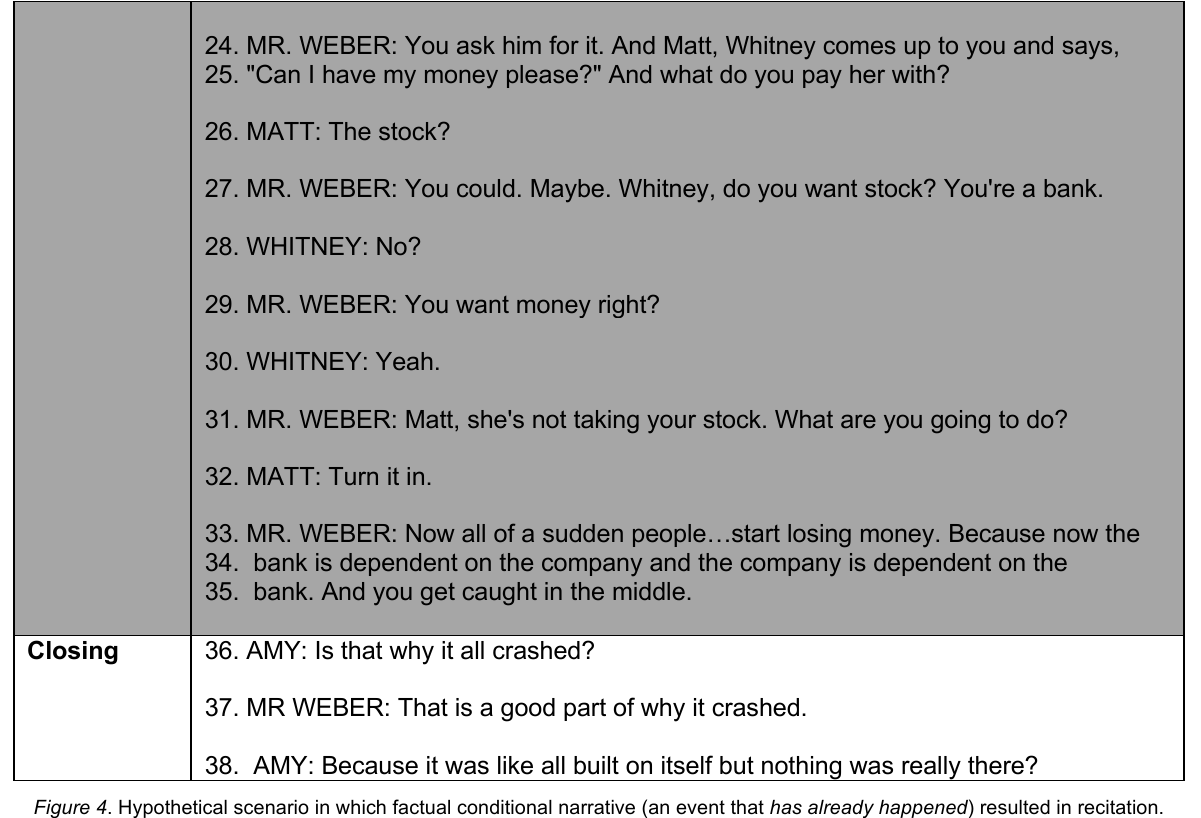
Figure 4 . Hypothetical scenario in which factual conditional narrative (an event that has already happened ) resulted in recitation. Lighter to darker shading indicates progression from open question to more constrained recitation-style